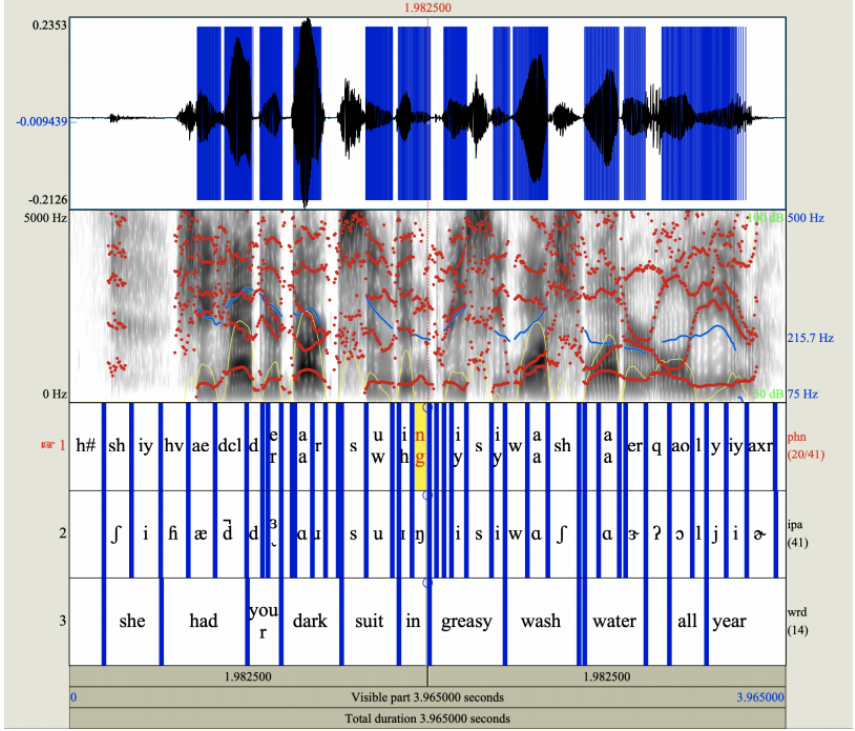
Figure 9. AB to IPA1